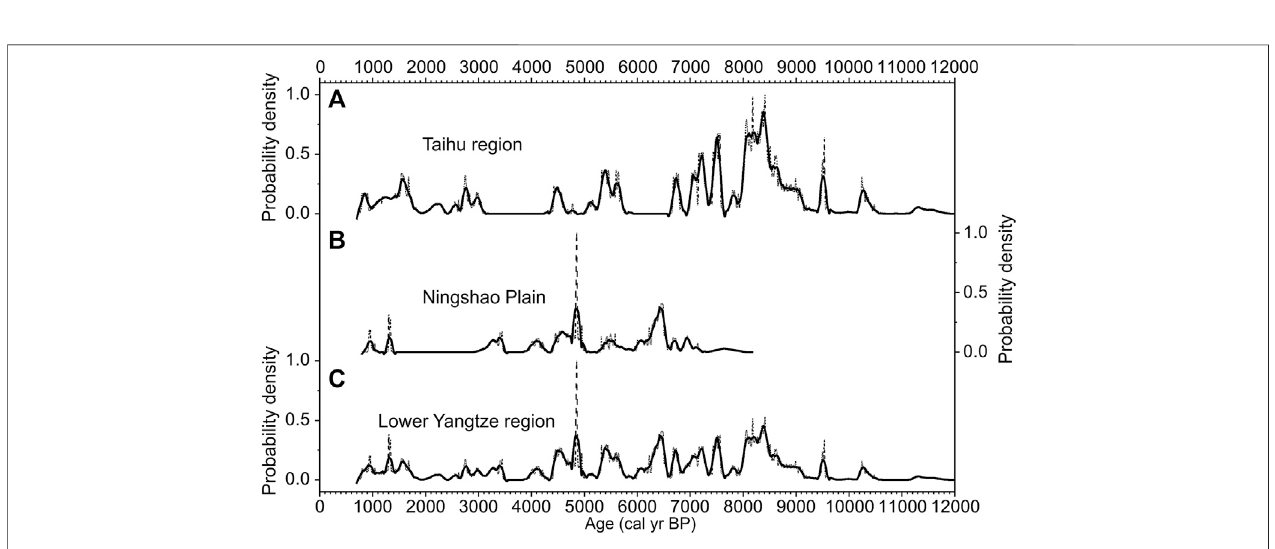
FIGURE 5 | Summed probability distributions (SPD) of radiocarbon dates of peat in the lower Yangtze region. (A) Taihu region. (B) Ningshao Plain. (C) Lower Yangtze region. Dotted curves show the SPD results and solid lines show the 200-point-smoothing of the SPD results.